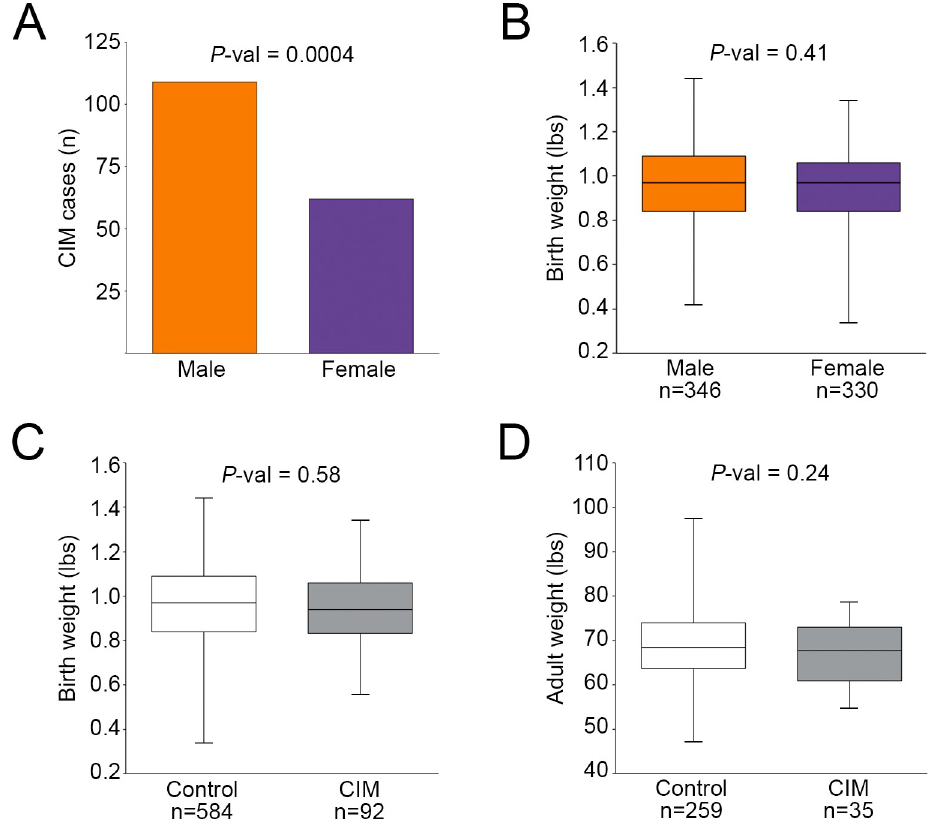
Fig 2. Phenotypic data from a private breeding colony. A) Bar graph of sex distribution in CIM cases shows a significant overrepresentation of males. Boxplots illustrate the absence of statistically significant differences in (B) birth weights between all males and females, (C) birth weights between affected and unaffected dogs, and (D) adult weights between affected and unaffected males.